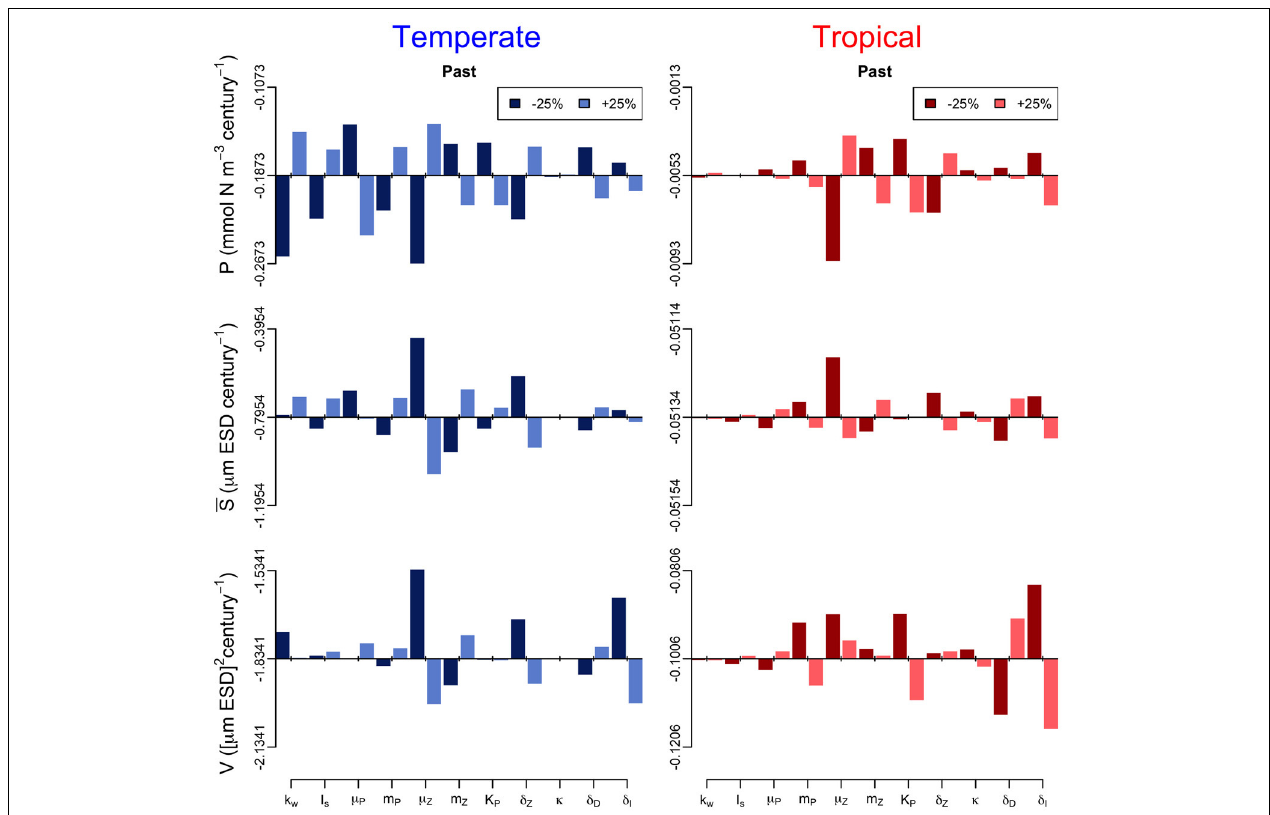
slope quantified in Supplementary Figure 2, and the bars represent the effect of the 25% alterations. For further details on the parameter values used